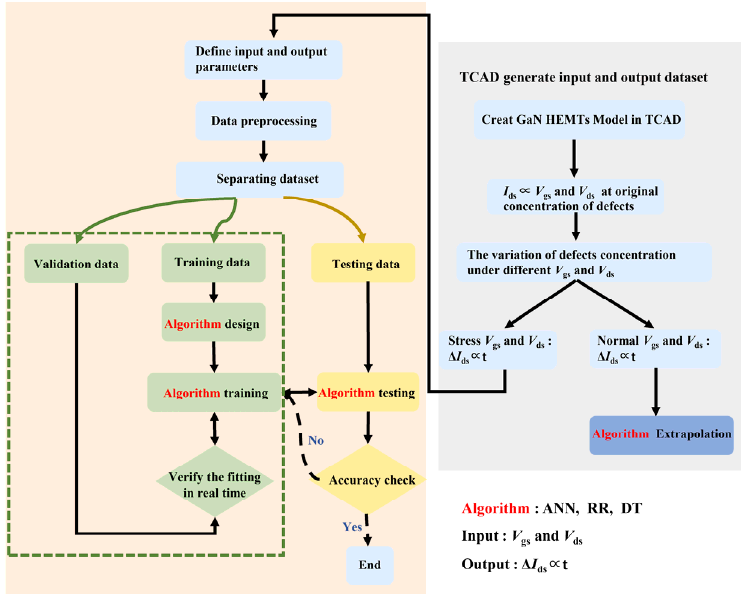
Figure 1. Flowchart of the ML-TCAD coupled model to predict the performance degradation of GaN HEMTs.